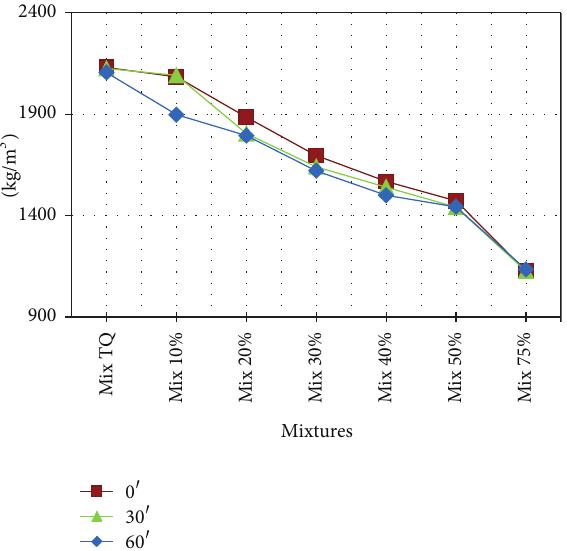
Figure 3: Density of rubber cement